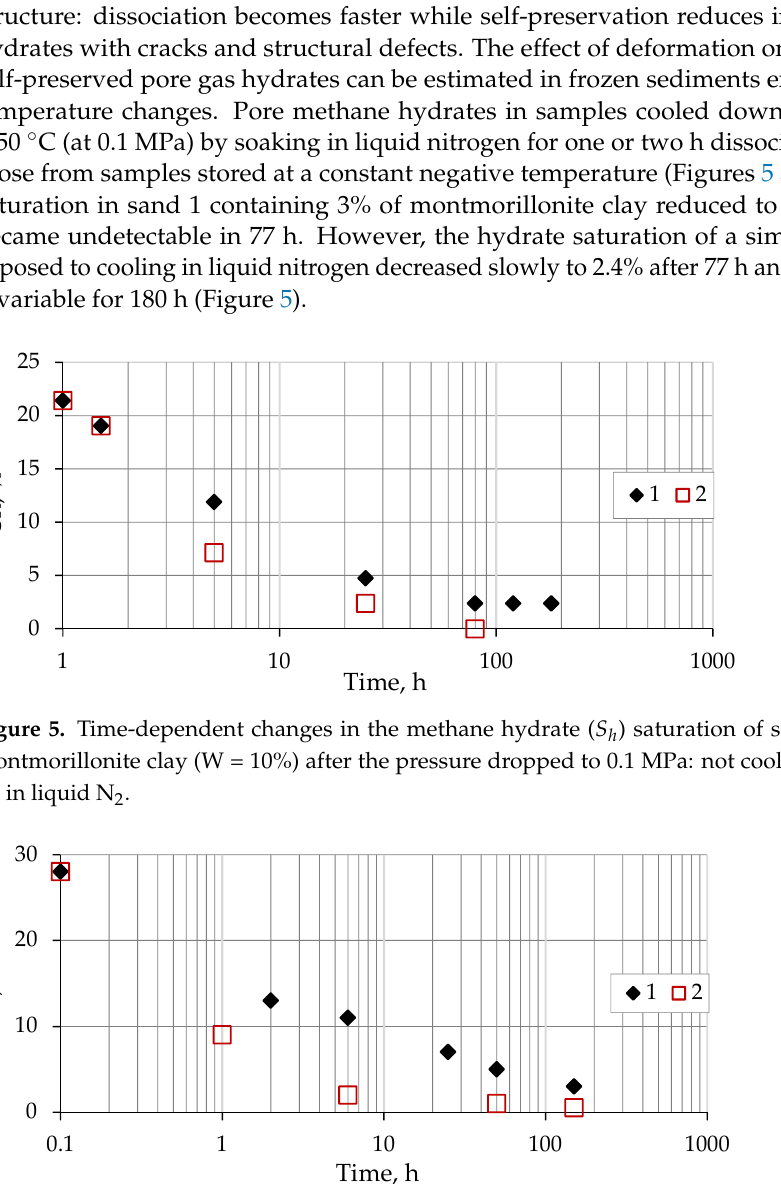
cooling was ~3% (Figure